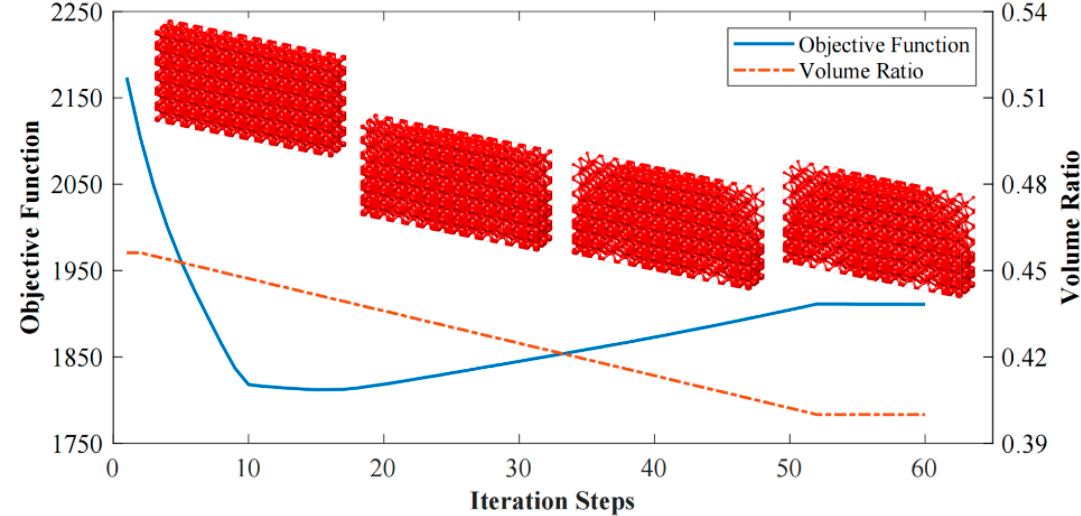
Figure 13. Interaction history of 3D Michell beam design.